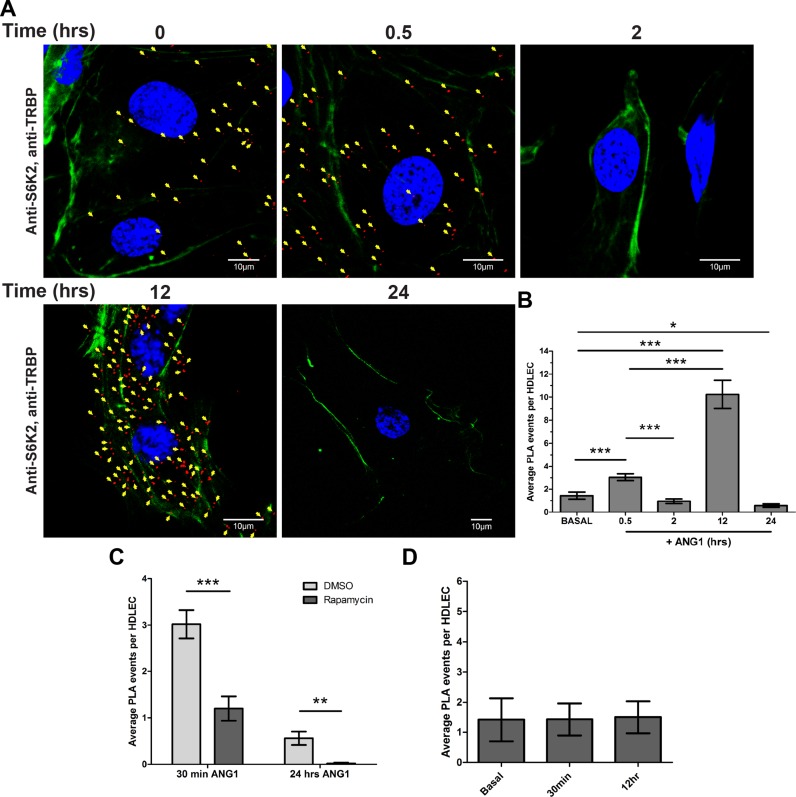
S6K2, but not S6K1, interacts with TRBP during ANG1 treatment of HDLECs. (A) Analysis of TRBP and S6K2 interaction by PLA (red) in HDLECs during 24 h ANG1 stimulation. Nuclei (blue) and F-actin (green) staining are presented in addition (scale bar: 10 μm). PLA events (in red) are indicated with yellow arrows. (B) Bar graph illustrating mean number of TRBP/S6K2 PLA events detected in HDLECs cultured in basal media or following overnight growth factor withdrawal and post 30 min, and 2, 12 and 24 h ANG1 stimulation. (C) Bar graph illustrating mean number of TRBP/S6K2 PLA events detected in HDLECs pre-treated with DMSO or Rapamycin (10 nM) for 2 h prior to 30min and 24 h ANG1 stimulation. (D) Bar graph illustrating mean number of TRBP/S6K1 PLA events detected in HDLECs cultured in Basal media or following overnight growth factor withdrawal and post 30 min, or 12 h ANG1 stimulation. Values presented are means ± SD. P values are shown (*P < 0.05; **P < 0.01; ***P < 0.001).